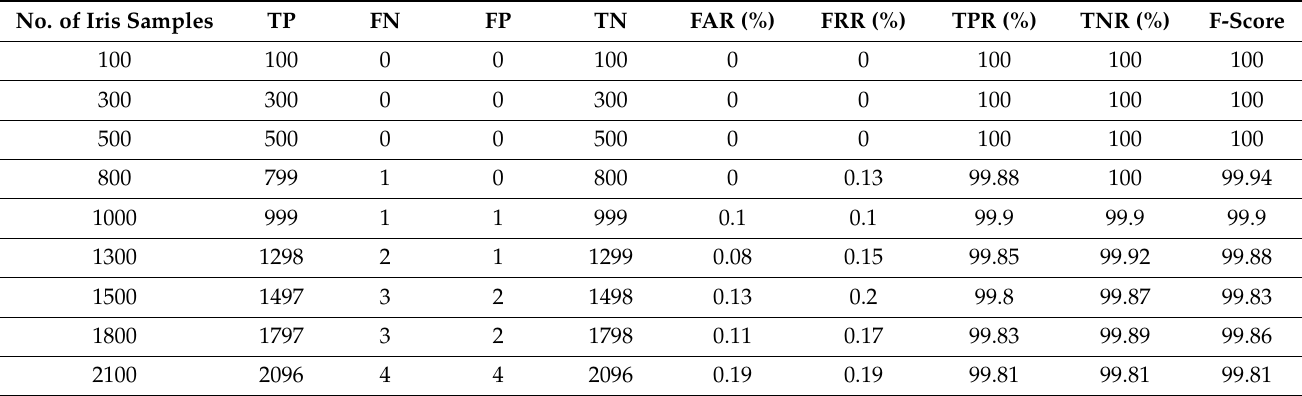
Table 2. Performance evaluation of cancelable approaches (HGLD, signcryption) on the IITD Iris dataset.